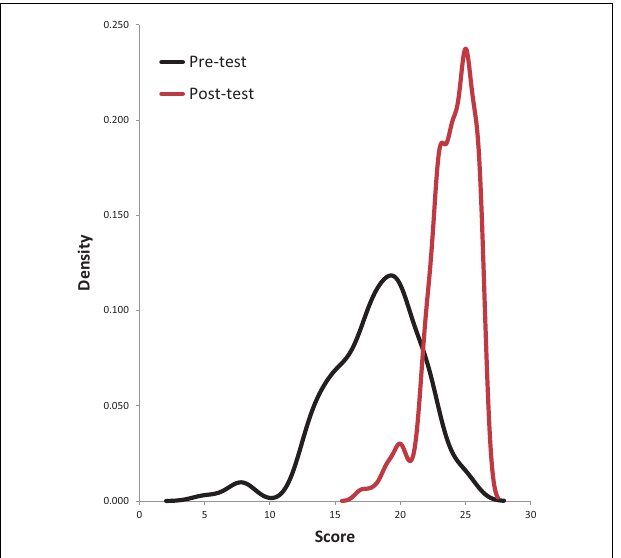
TABLE 3 | Pre- and post-test total score on the Knowledge Questionnaire Of Adolescent Depression For School Staff . Total score range